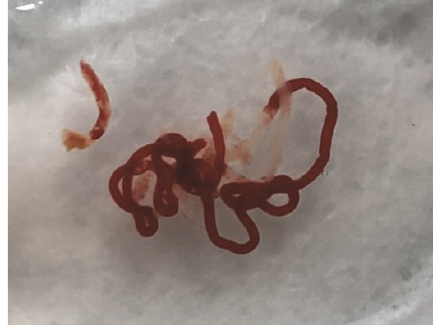
Figure 1: Fresh specimen obtained with a 22-gauge Franseen needle. Fragments of whitish tissue can be detected macroscopically between the blood